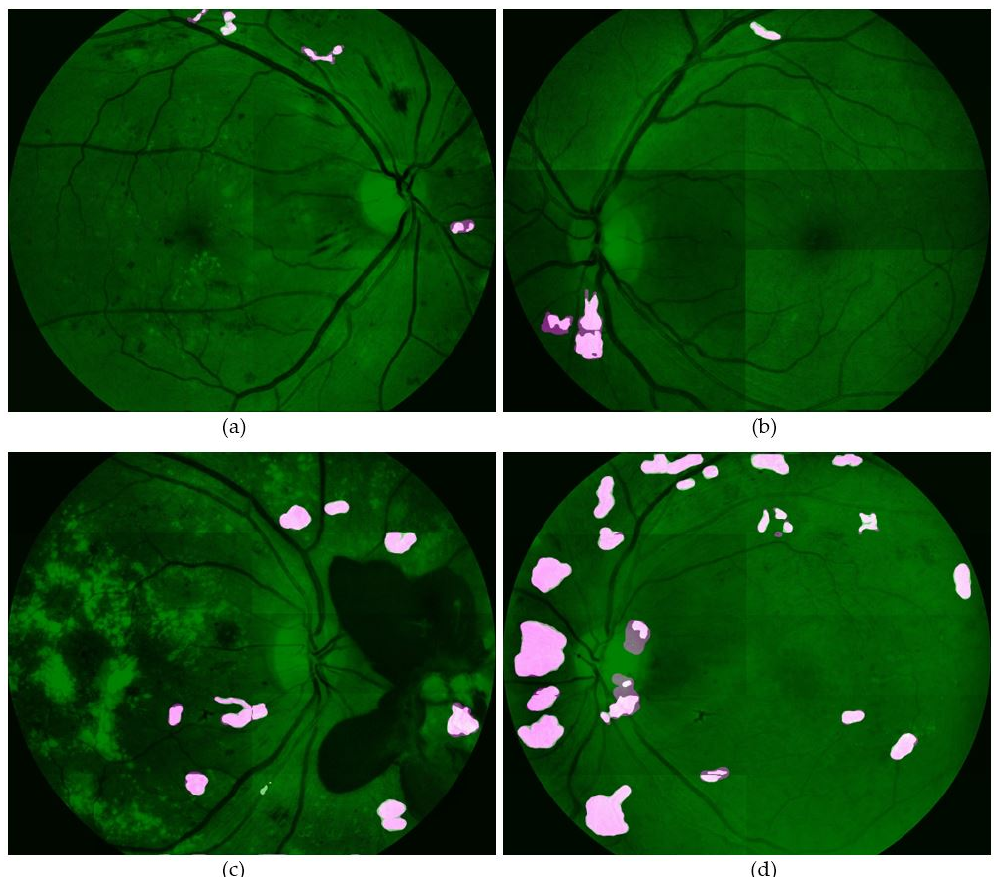
Figure 10. Several output images from the testing set are shown in ( a – d ). Note that the complete by combining the image